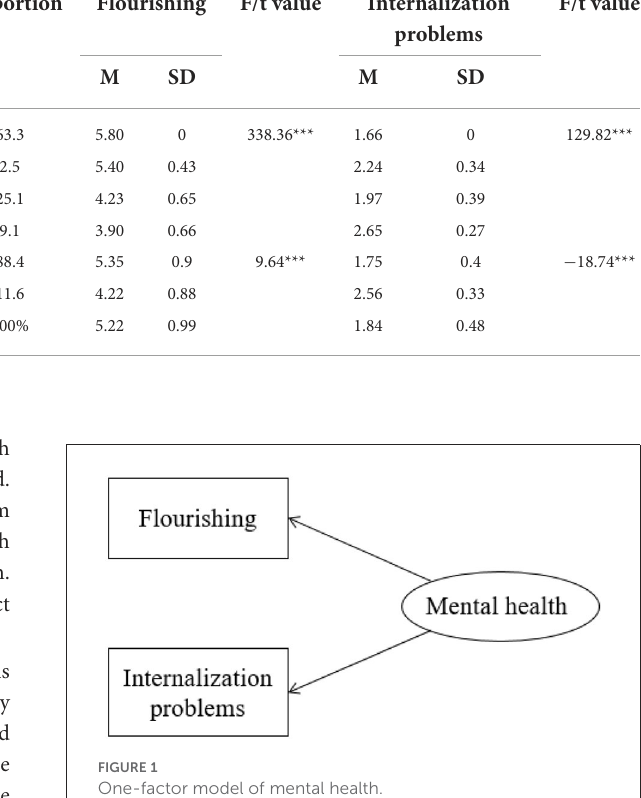
TABLE 3 Comparison of DFM quartering method and one-factor model classification method. Type